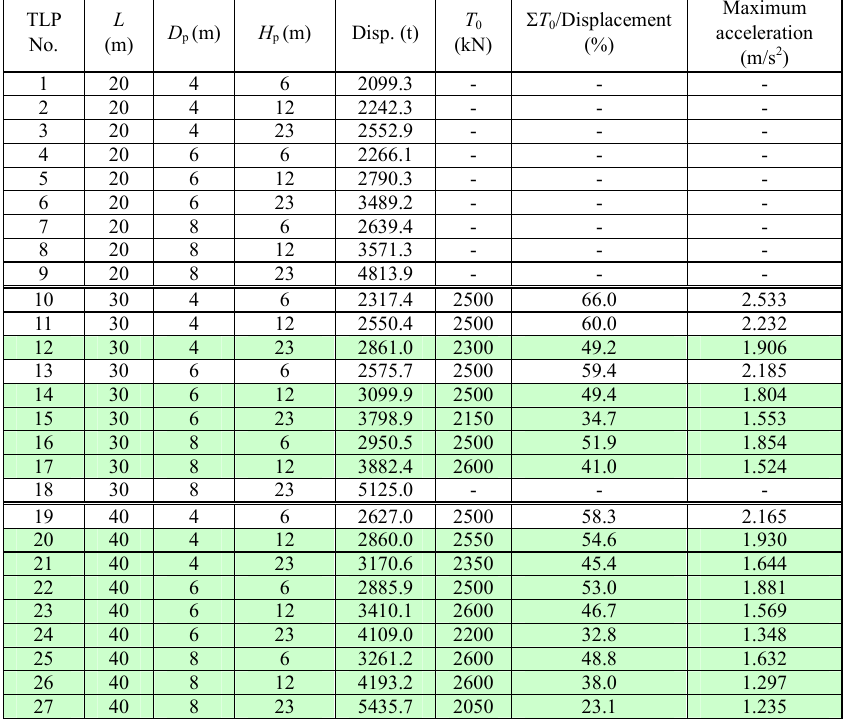
Fig. 14, the maximum accelerations are plotted against the displacement of the TLP. A trade-off between the acceleration and displacement is observed in which low acceleration needs large displacement, which might be in proportion to the cost of the structure. In Fig. 15, the total initial tension is shown as a function of displacement. The range of possible initial tensions is from 34% to 50% for L = 30 m and from 23% to 55% for L = 40 m, thus it is found to become wider with increasing span length. =6, 12m and H =23m, where In Fig.15, results are classified into two groups, i.e. H p p the peripheral columns of the former are submersible whereas the latter is semi-submersible. From the regression lines for these groups, it can be concluded that regardless of the size of the span length and diameter of the peripheral column, T =2548(kN) and T =2279 (kN) are reasonable estimates for the TLP with submersible 0 0 peripheral columns and semi-submersible columns, respectively. Table 3. Structural parameters and the maximum acceleration at hub height